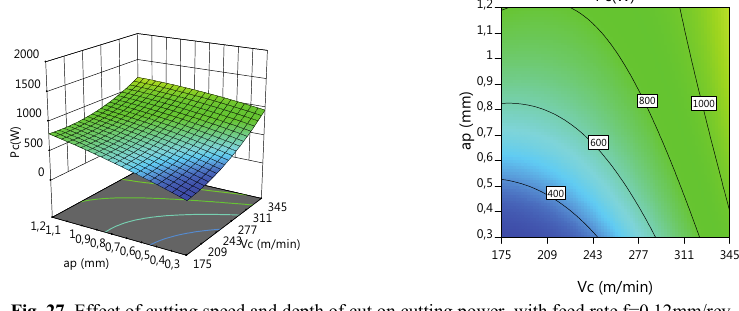
Fig. 27. Effect of cutting speed and depth of cut on cutting power, with feed rate f=0.12mm/rev